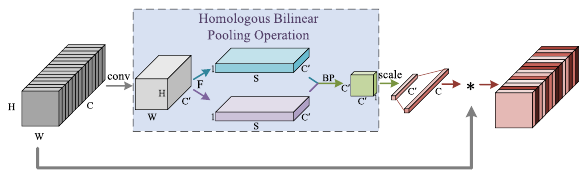
Fig. 2 The proposed bilinear pooling attention module (BPAttLayer)